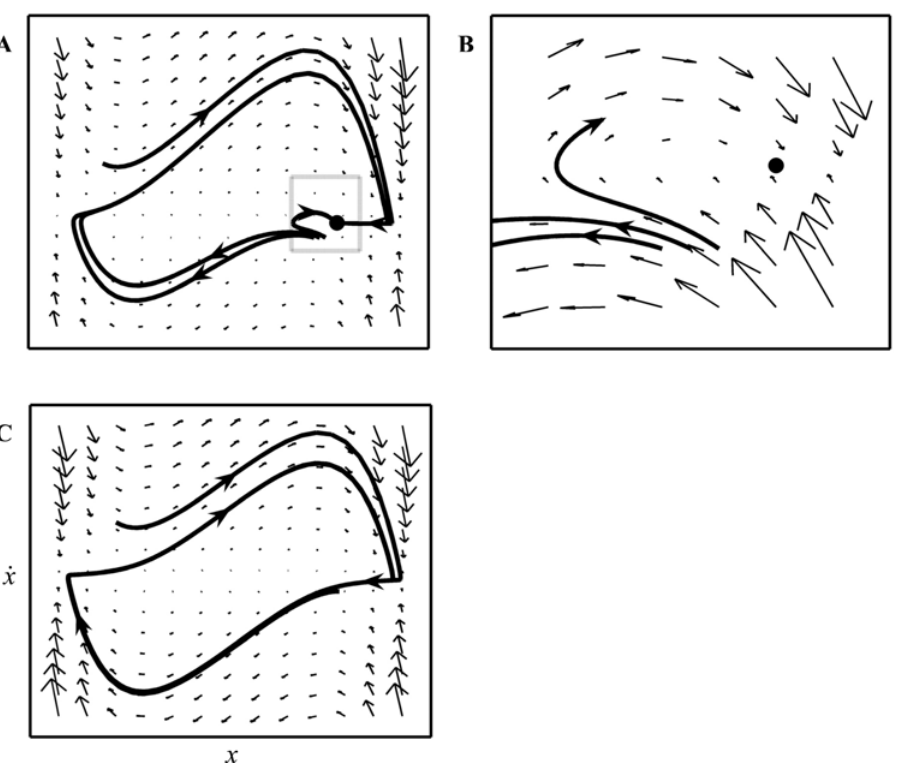
Figure 1. Phase space topologies. The small arrows delineate the phase flow. Horizontal axes represent position ( x ); vertical axes represent velocity ( _ xx ) (only indicated in [C]). (A–B) Stable fixed point and separatrix. A close-up of the dotted-boxed area in (A) is provided in (B). A stable fixed point is represented by the black point; arrows converge to it. The divergence of nearby starting trajectories reveals locally distinct flows set apart by a separatrix. (C) Stable limit cycle.